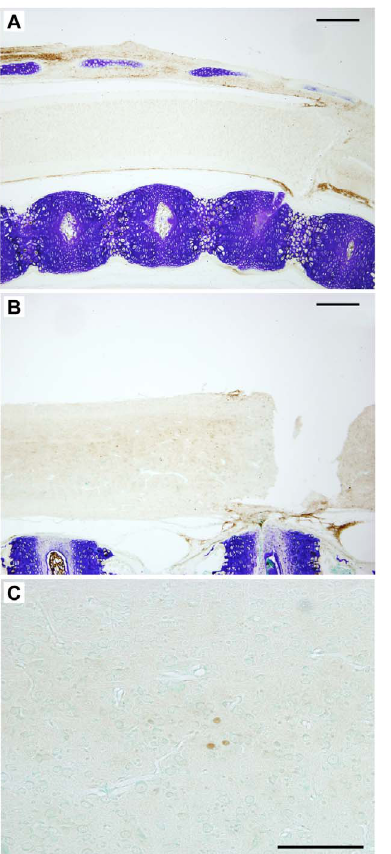
Figure 4. Interleukin-1 b in Monodelphis spinal cord 24 hours after a complete transection at P7 or P28. In the segment of the cord rostral to the site of injury Il-1 b was detected using cross-reacting antibodies to the human cytokine. Note strong immunopositive signal in the tissue surrounding the cords at P7-injured (A) and P28 (B) but lack of significant staining within the spinal tissue especially at P7 (A). One day following injury at P28 a few immunopositive cells with the general morphology of monocytes were detected, especially in segments of the cord more rostral to the injury (C). Scale bars A, B=500 m m, C=100 m m.